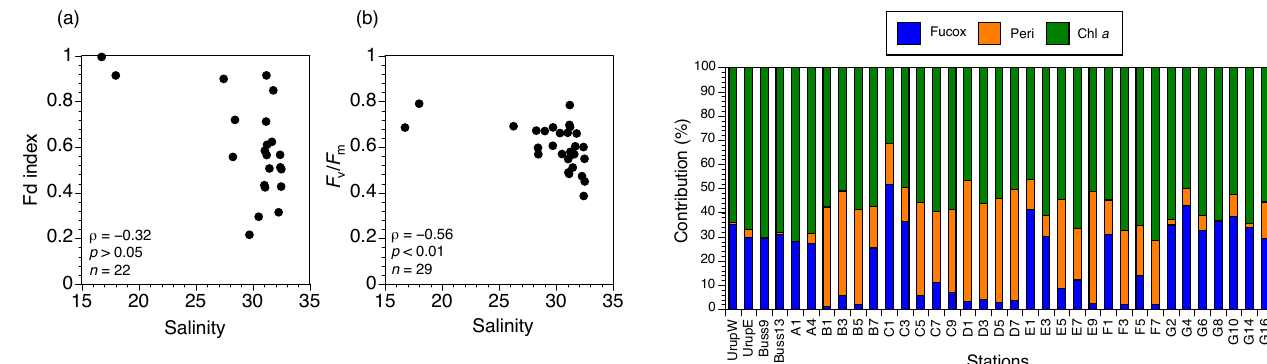
Fig. 7. Relationships between salinity and (a) the Fd index values for micro-sized diatoms or (b) F v / F m for total micro-sized phyto- plankton in surface waters off Sakhalin Island.